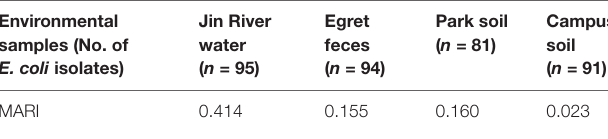
TABLE 2 | Multiple antibiotic resistance indexes (MARIs) of environmental samples. Environmental samples (No.